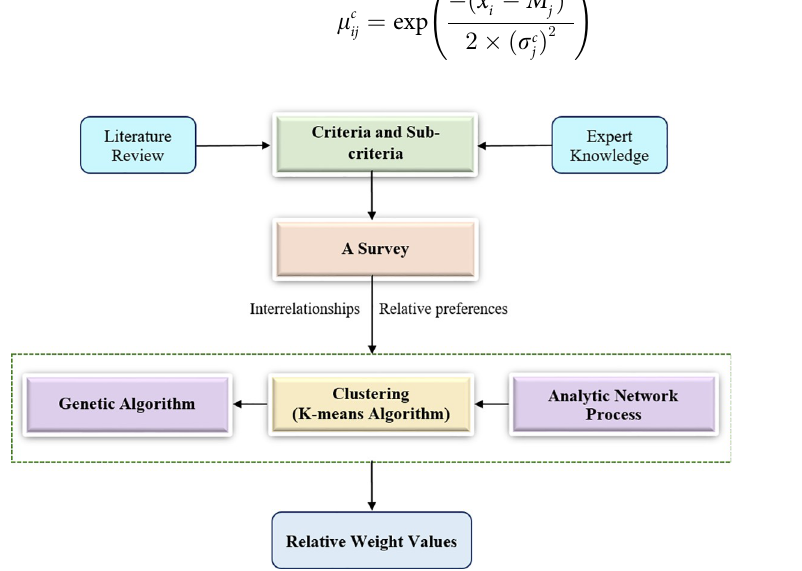
Fig 1. The integrated approach between the GA and the ANP